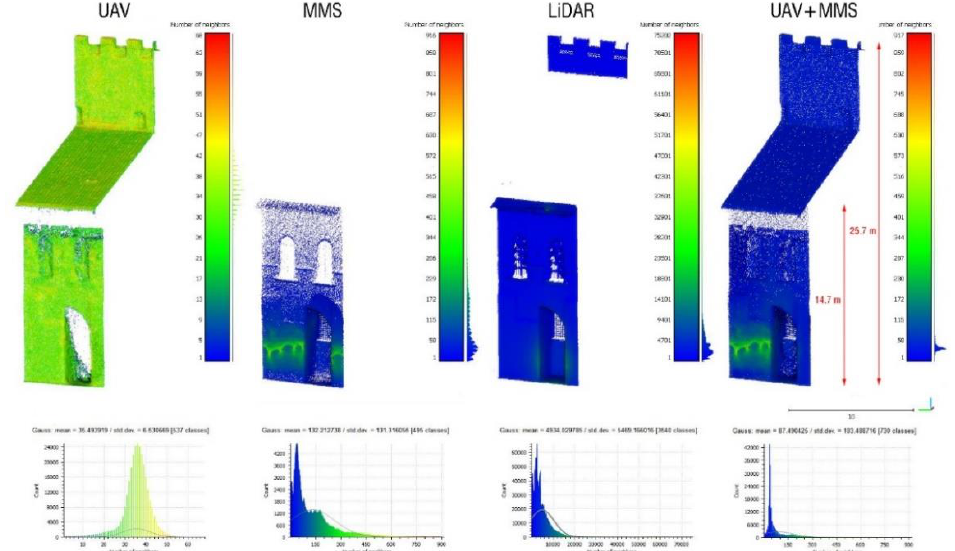
Figure 8. Analysis of the point cloud density for each sensor and for the integration between Mavic Pro and Zeb Revo point